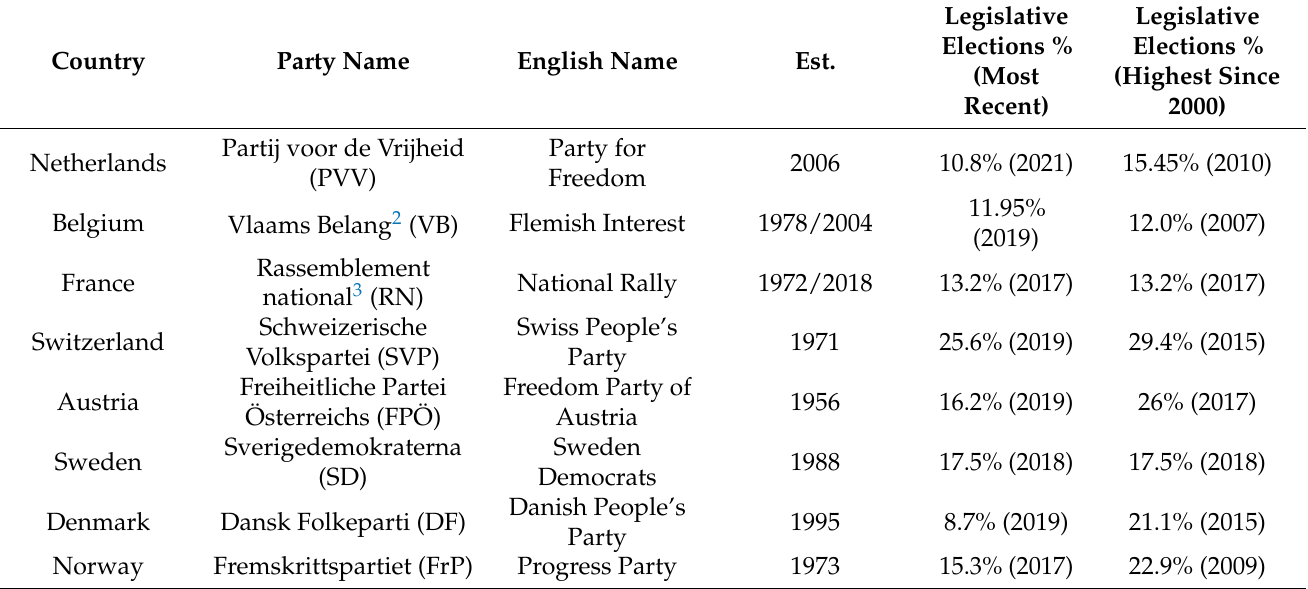
Table 1. “Christianist” Populist Parties of Western and Northern Europe (as identified by Brubaker 2016,